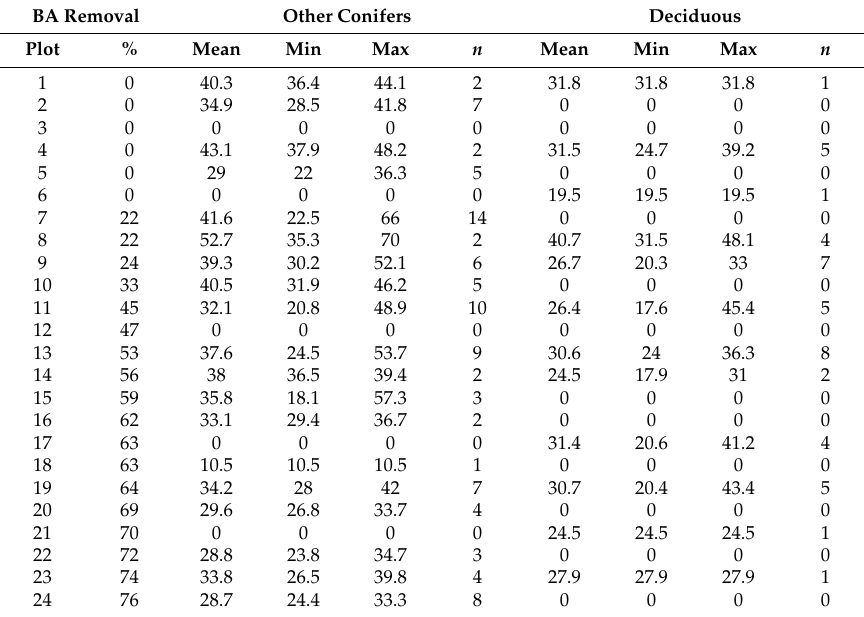
Table A2. Summary statistics for DBH of other conifers and deciduous species sampled in the 24 plots by percent basal-area removal and tree